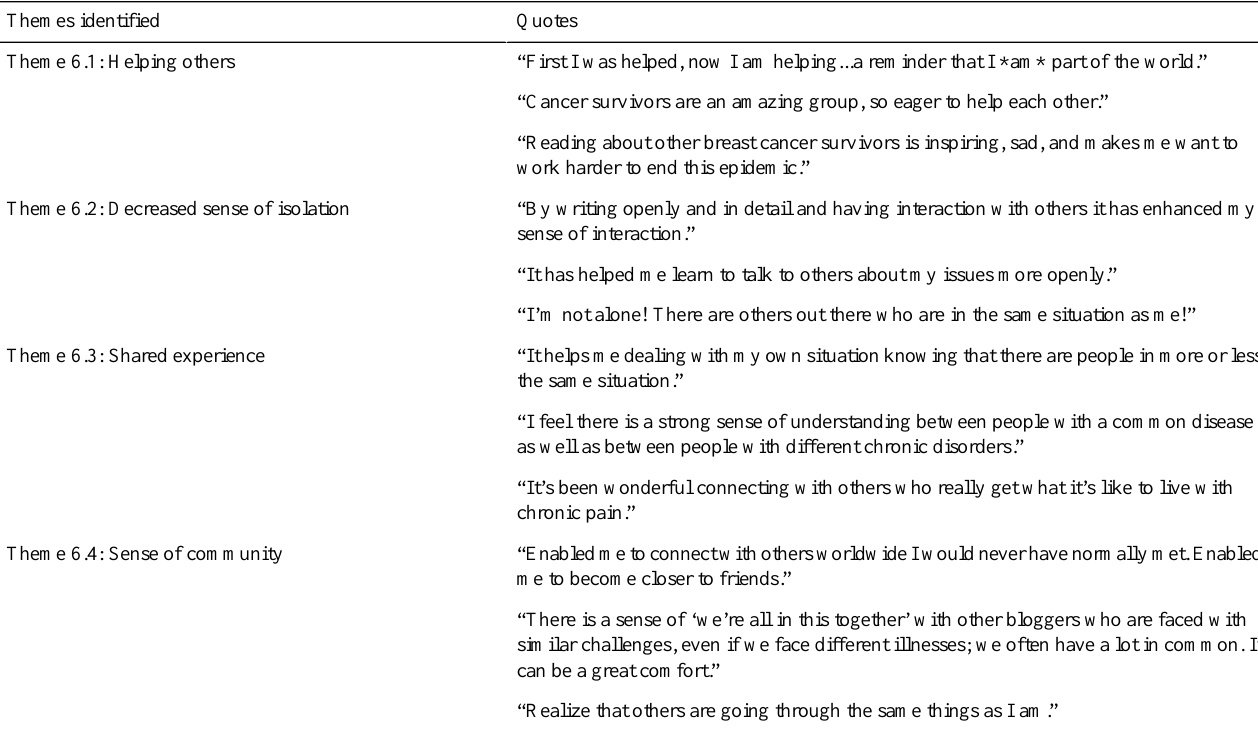
Table 8. Sense of connection cultivated through blogging.